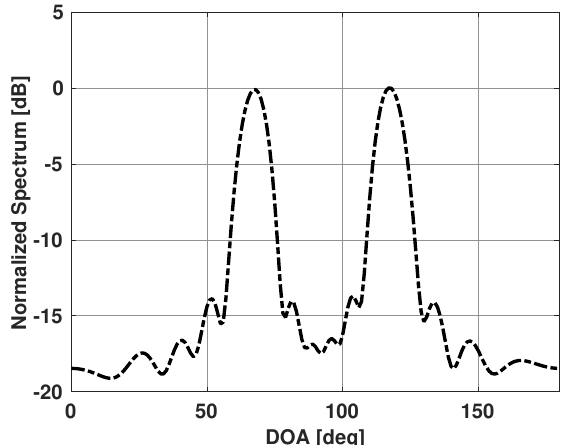
Figure 2. Bartlett spectrum versus DOA for a uniform linear array of 15 elements in the presence of four signals incident at 65 ◦ , 70 ◦ , 115 ◦ , and 120 ◦